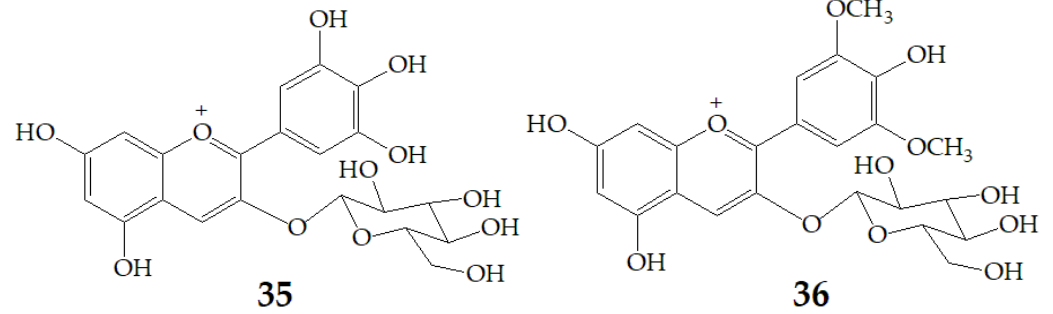
Figure 10. Chemical structures of compound 35 , 36 .